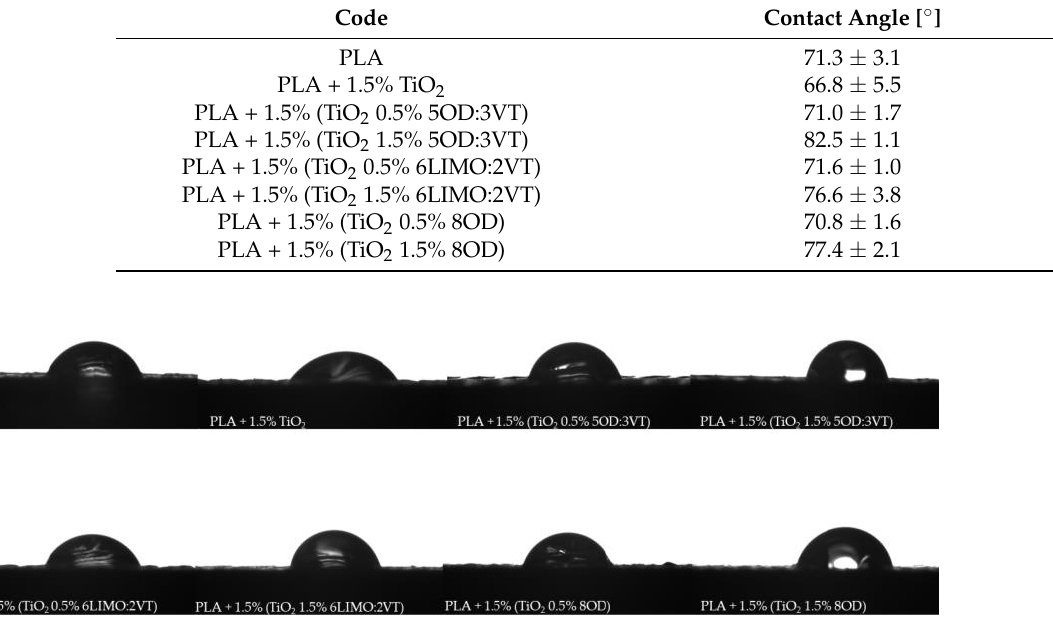
Figure 6. Images of water droplets during sessile drop analysis for composites. Table 6. Water contact angle of composites [°].